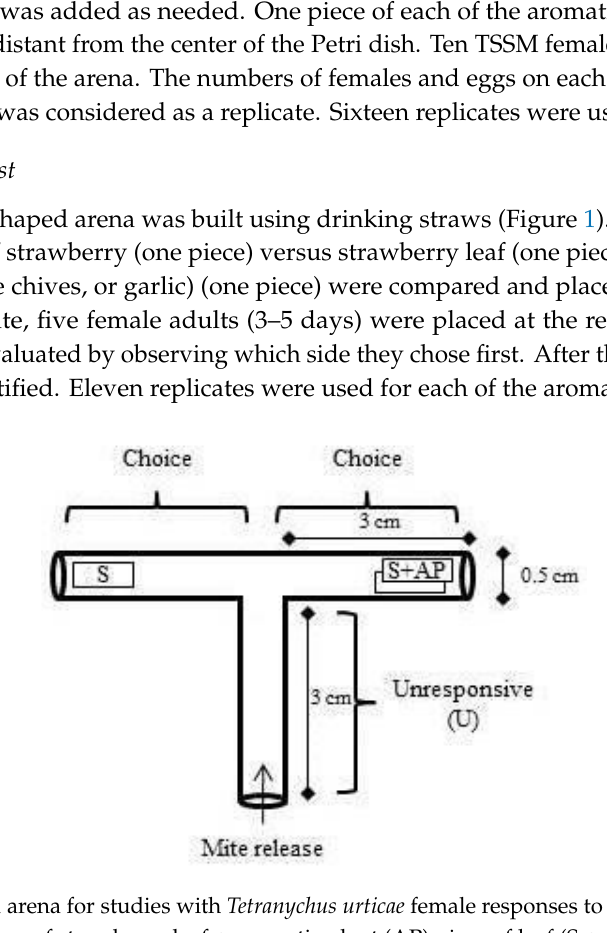
Figure 1. T-shaped arena for studies with Tetranychus urticae female responses to a piece of strawberry leaf (S) versus a piece of strawberry leaf + aromatic plant (AP) piece of leaf (S +